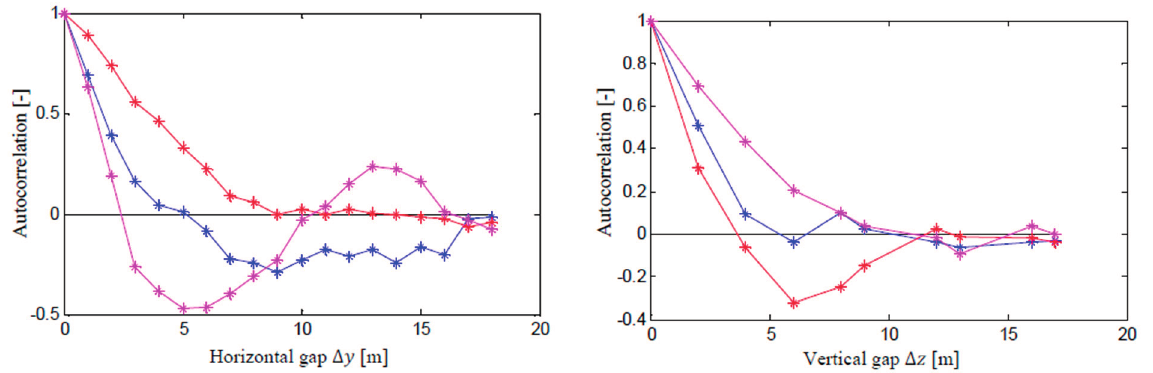
Figure 11. Lateral and vertical correlation for the three components. Blue: u -component, red: v -component; purple: w